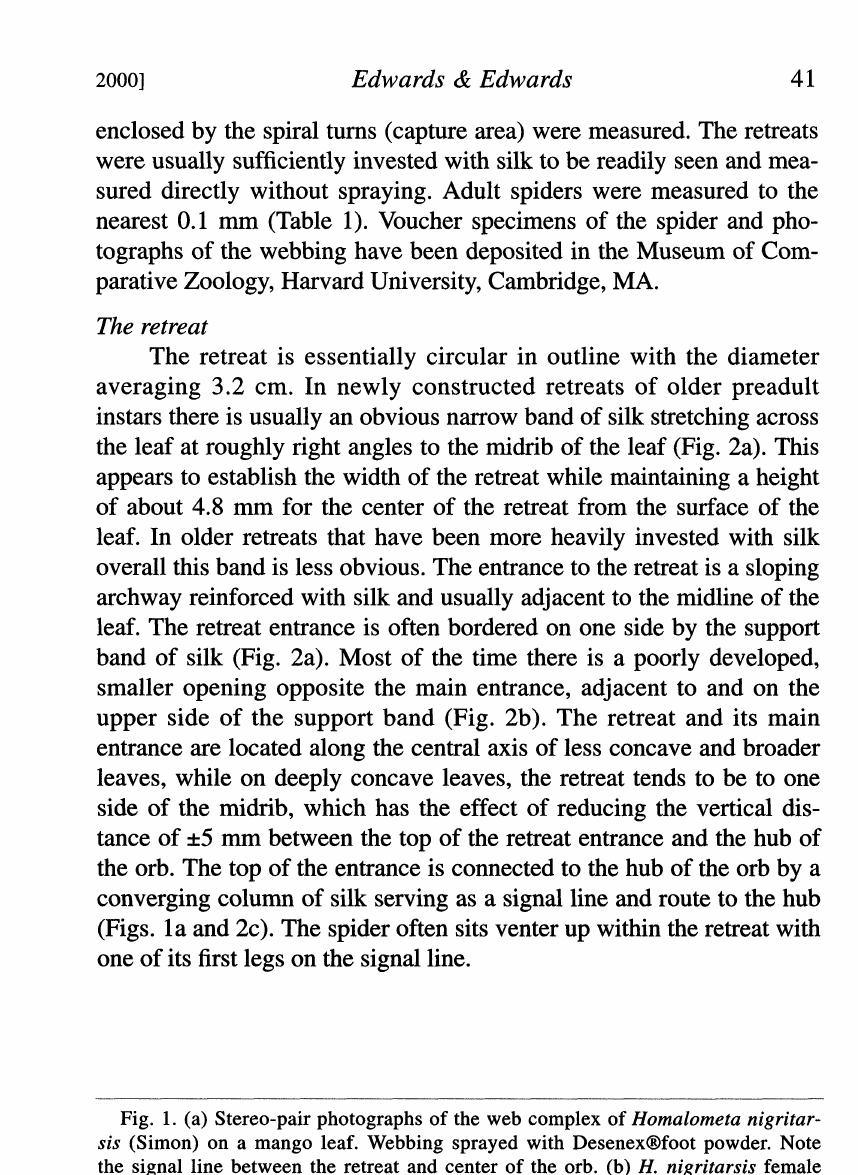
Fig. 1. (a) Stereo-pair photographs of the web complex of Homalometa nigritar- sis (Simon) on a mango leaf. Webbing sprayed with Desenex(R)foot powder. Note the signal line between the retreat and center of the orb. (b) H. nigritarsis female under the hub of the orb-web with eggs and newly hatched spiderlings. Within the retreat is a row of eight eggs on the left and five egg shells on the right. Recently hatched first instar spiderlings soon shed their exuvia where they remain on the upper surface of the retreat. The entrance to the retreat has a faintly defined arch approximately halfway between the spider and the eggs. The webbing is not sprayed with powder. Note that the orb does not show up. Scale bar